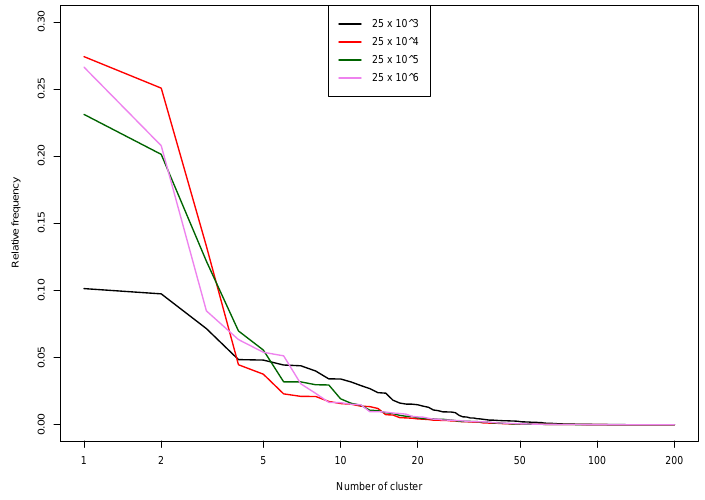
Figure 10. Relative frequency of observations by cluster, in decreasing order, for different sample sizes, n = 10 3 ,10 4 ,10 5 ,10 6